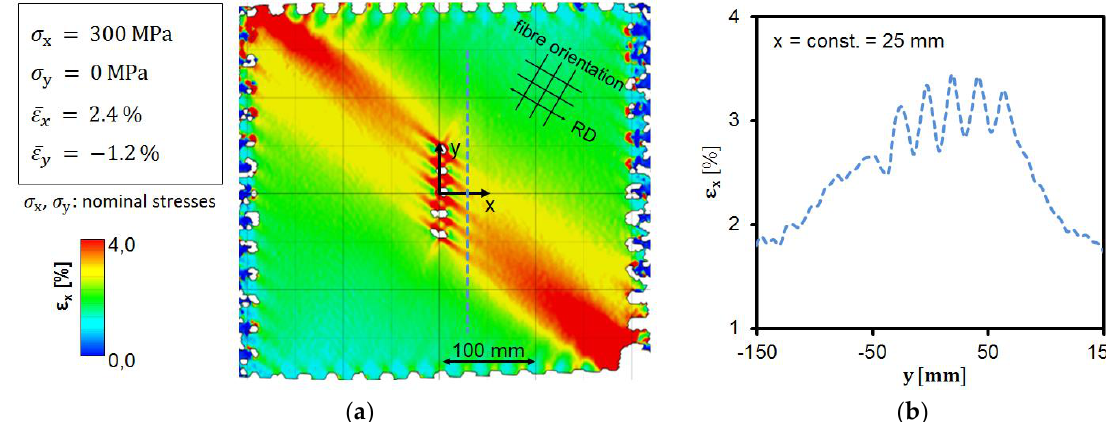
Figure 8. ( a ) Strain field for biaxial specimen with off-axis angle of α = 30 ◦ tested with a biaxiality ratio of λ = 0. ( b ) Strain profile for x = 25 mm through cut from ( a ) (dashed blue line).